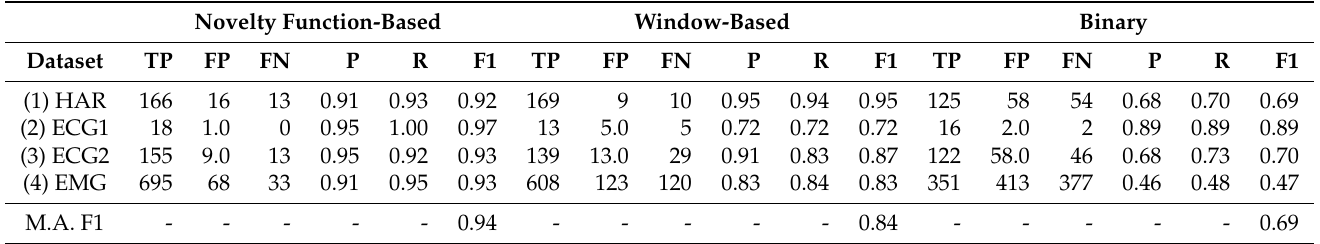
Table 1. Results obtained by experiments with the novelty function-based, window-based, and binary segmentation approaches on different datasets, including true positives (TP), false positives (FP) and false negatives (FN), precision (P), recall (R) and F1-score (F1) values. The last row provides the macro averaged F1-scores (M.A. F1) of the four datasets.